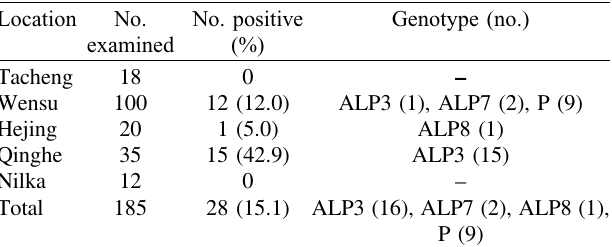
Table 1. Enterocytozoon bieneusi prevalence in alpacas from Xinjiang, northwestern China.